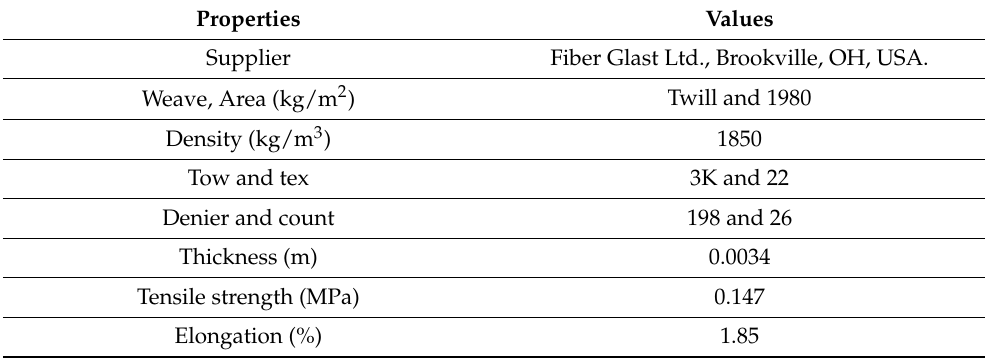
Table 2. Details of carbon fabric [31].